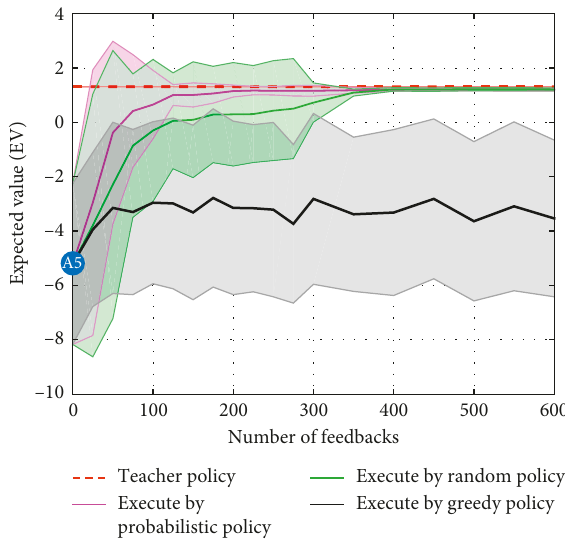
Figure 8: The performance of IRLDC under different exploration policy types used in the interactive phase (stage-two) when 100 state-action pairs of 60% optimal demonstrations are given (see Table